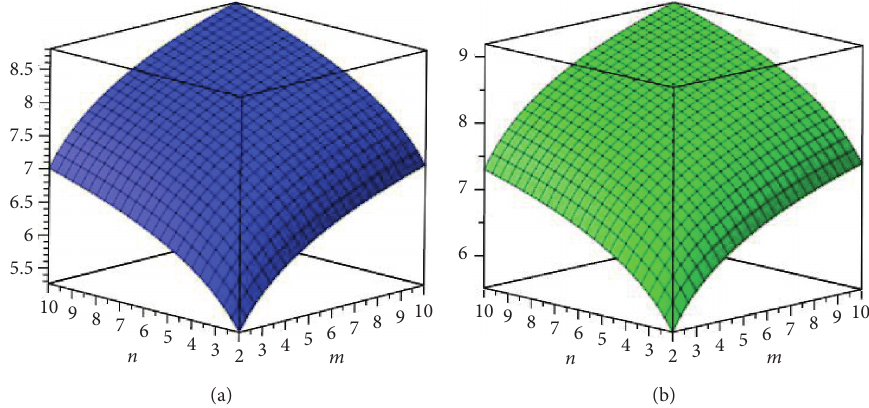
Figure 8: (a) The first Zagreb entropy; (b) the second Zagreb entropy.